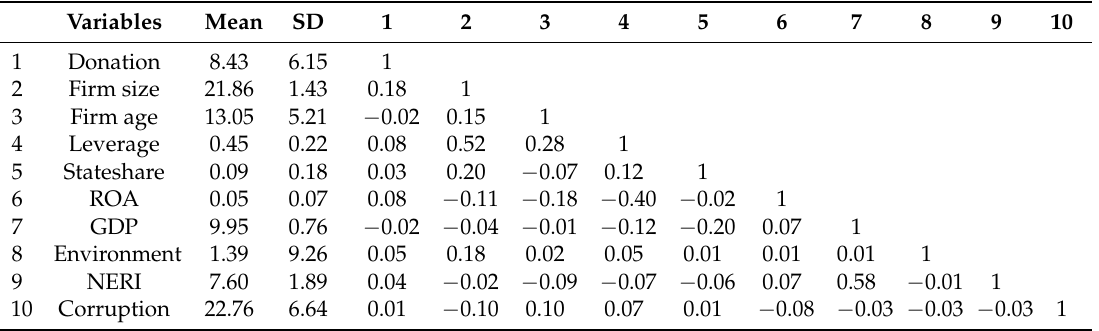
Table 2. Descriptive statistics and correlation matrix